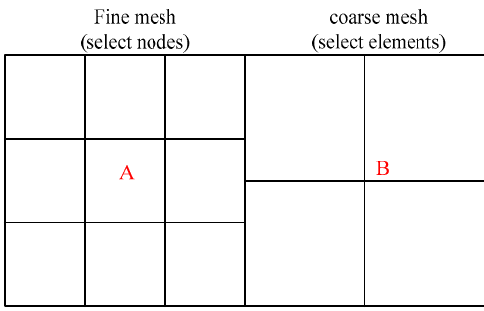
Figure 4. Schematic diagram of mesh coupling.